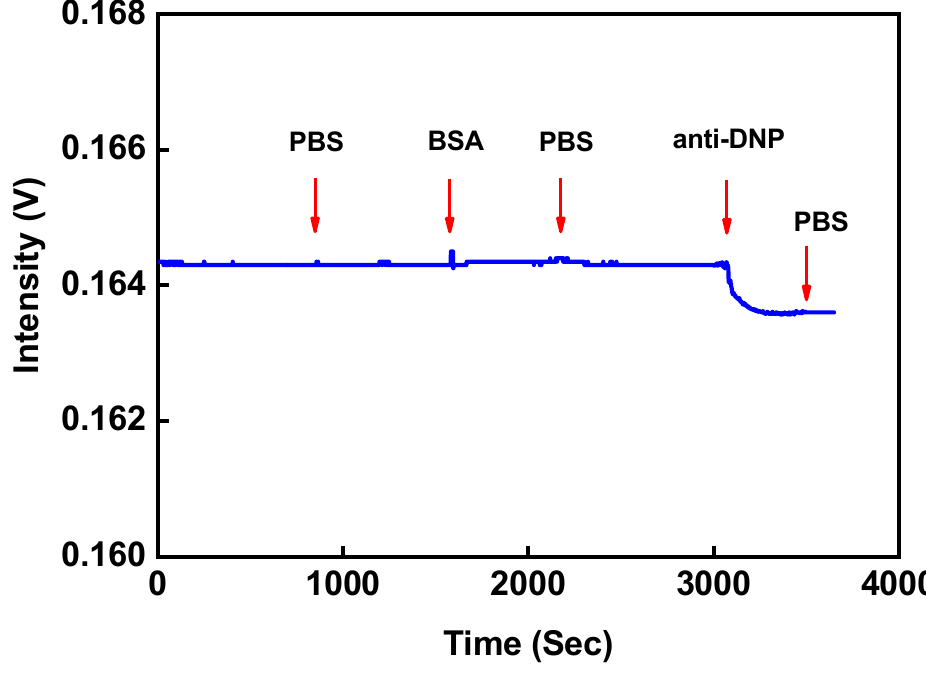
Figure 7. Nonspecific adsorption tests: Nonspecific adsorption tests. The sensorgram of DNP- functionalized FOPPR sensor in response to solutions.